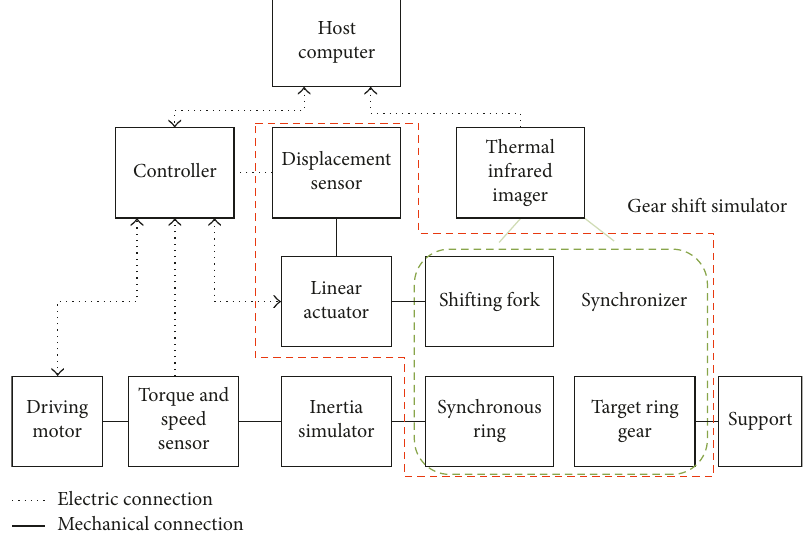
Figure 3: Schematic of experimental